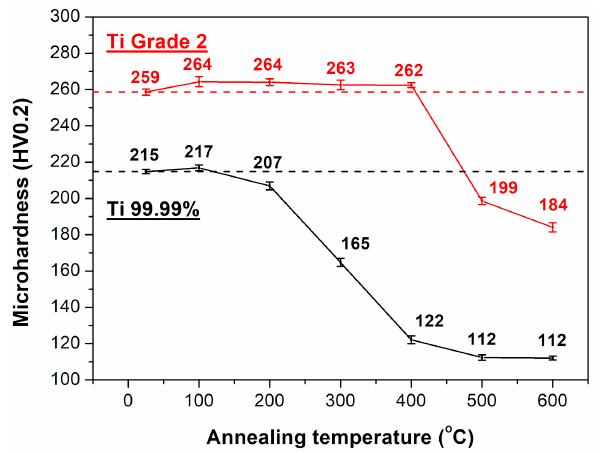
Figure 2. The variation of Vickers microhardness for Ti 99.99% and Ti Grade 2 after annealing at 100–600 °C.